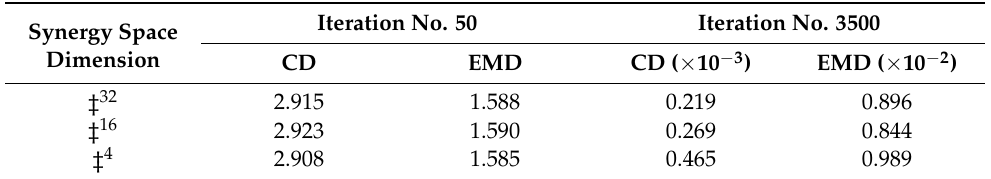
Table 1. The mean value of CD and EMD reconstruction errors by the CNF decoder for three synergy dimensions.